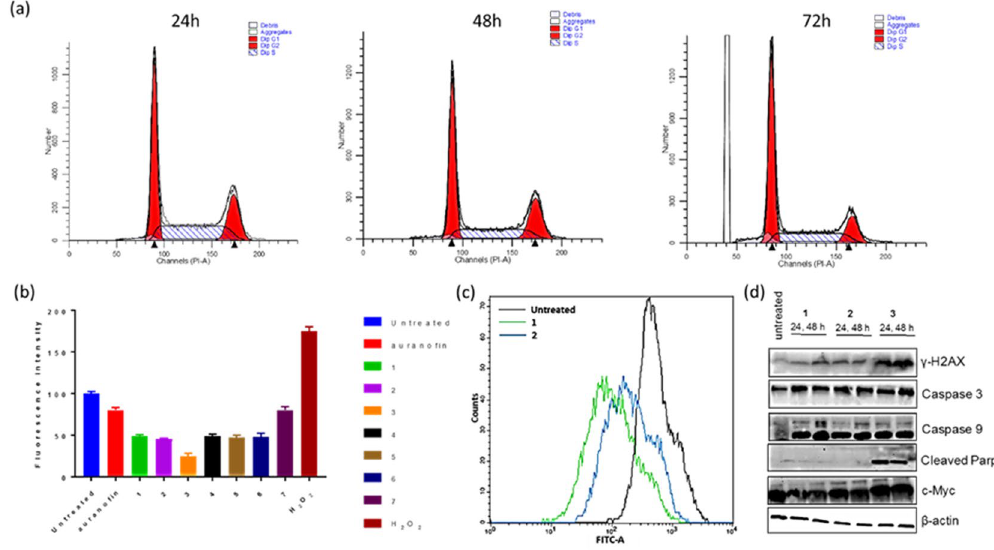
Figure 10. ( a ) Histogram representing the different phases of the cell cycle of OVCAR8 in the presence or absence 1 (2 µ M) over the course of 72 h. 24 h treated with 1 : G1: 42.22%, S: 36.39%, G2/M: 21.38%, 48 h treated with 1 : G1: 47.27%, S: 34.46%, G2/M: 18.26%, 72 h treated with 1 : G1: 54.99%, S: 29.48%, G2/M: 15.53%. ( b ) Intracellular ROS using OVCAR8 cells and dihydrorhodamine 123 as dye. Plots show untreated cells (negative control), H 2 O 2 treated cells (positive control), and cells treated with 1–7 (5 μ M, overnight) or auranofin (5 μ M, overnight). ( c ) Histogram plot of the effects of 1 and 2 ( µ M) on mitochondrial membrane potential using rhodamine 123 in OVCAR8 cells. ( d ) immunoblotting for the expression of apoptosis and DNA damage response proteins in OVCAR8 cells following incubation with 1 , 2 , or 3 . (full-length blots/gels are presented in Supplementary Fig.